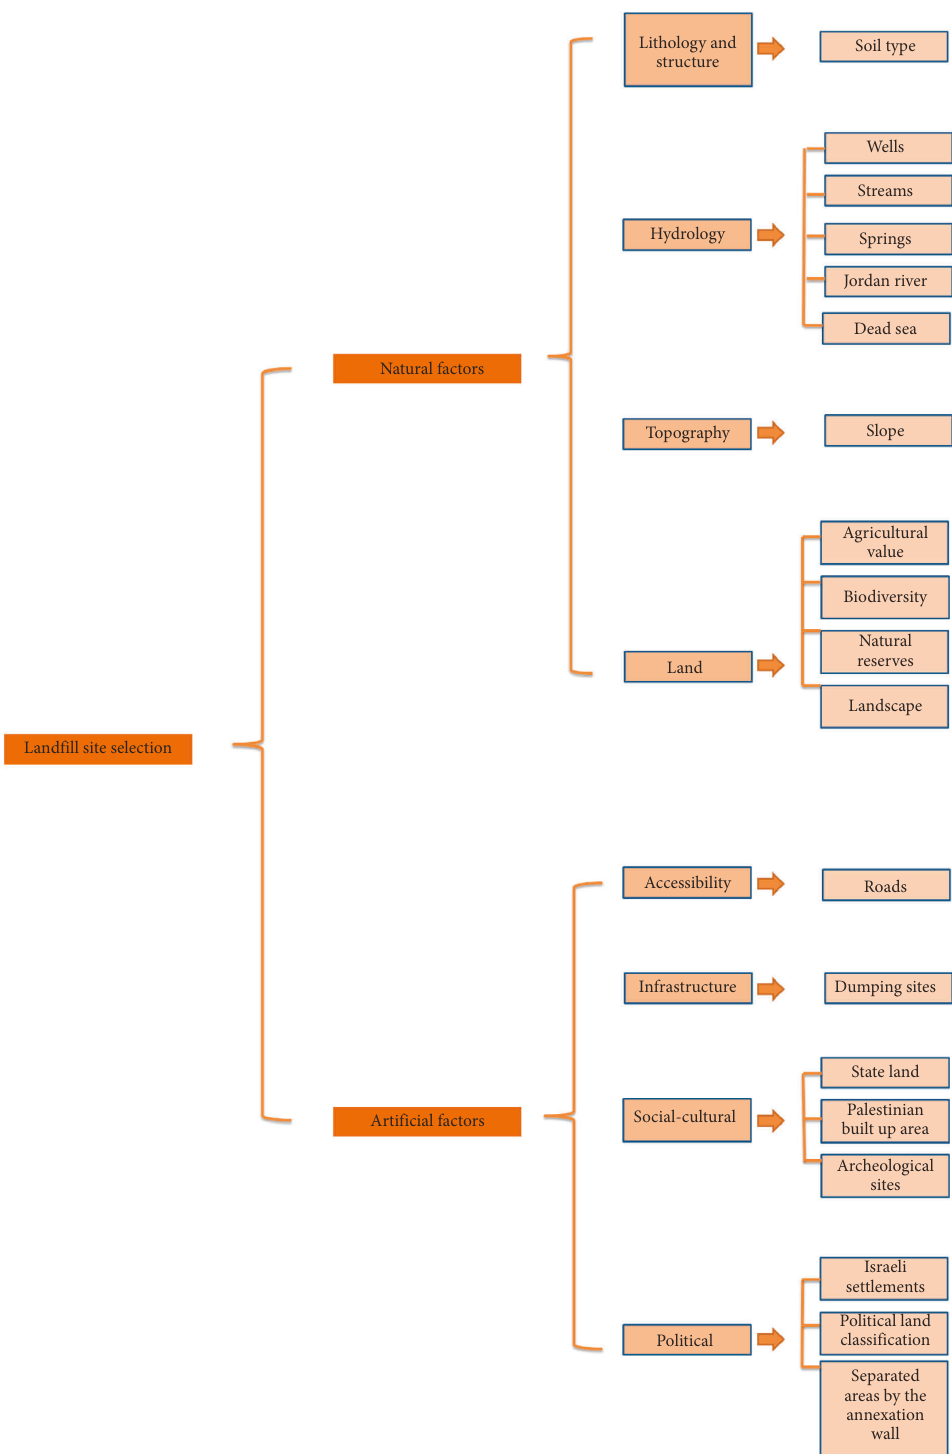
Figure 4: Hierarchical scheme of the decision process for landfill site